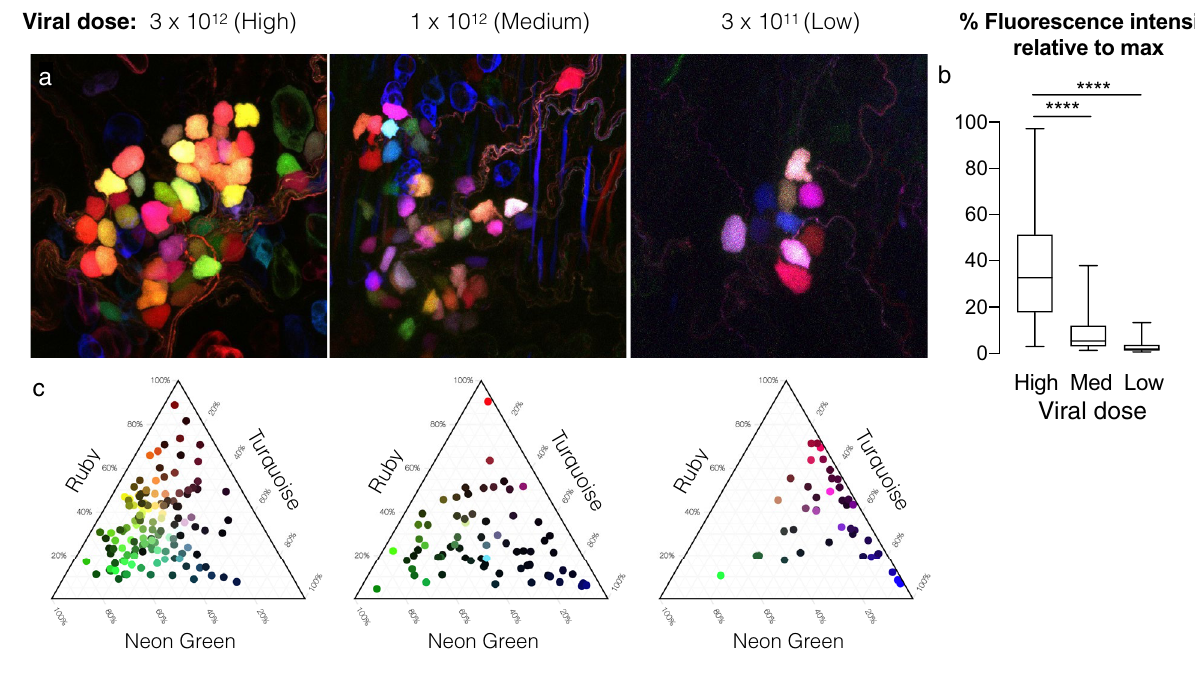
Figure 5. Fluorescence intensity of parasympathetic neurons dependent on viral dose. ( a ) Representative images of ganglia from three viral doses. ( b ) Fluorescence intensity represents the average intensity in a single nerve soma with the three color channels added together. Doses compared using a Kruskal–Wallis test with Dunn’s post-hoc test. *p < 0.01, ****p < 0.0001. n = 41–139. ( c ) Ternary plots for each dose were used to assess color spread, with the normalized fluorescent intensity of each neuron cell body plotted as a proportion of the three possible colors. Color variation was smaller (points clustering towards the center of the chart) in the high dose, was skewed toward the Turquoise vector in the low dose, and was most evenly distributed in the middle dose.